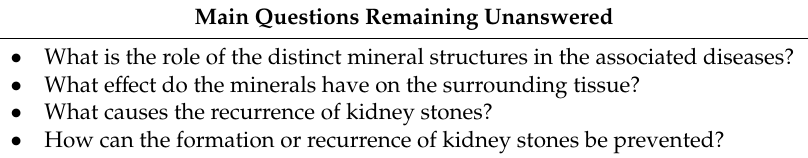
Table 4. List of main questions that remain unanswered in relation to kidney